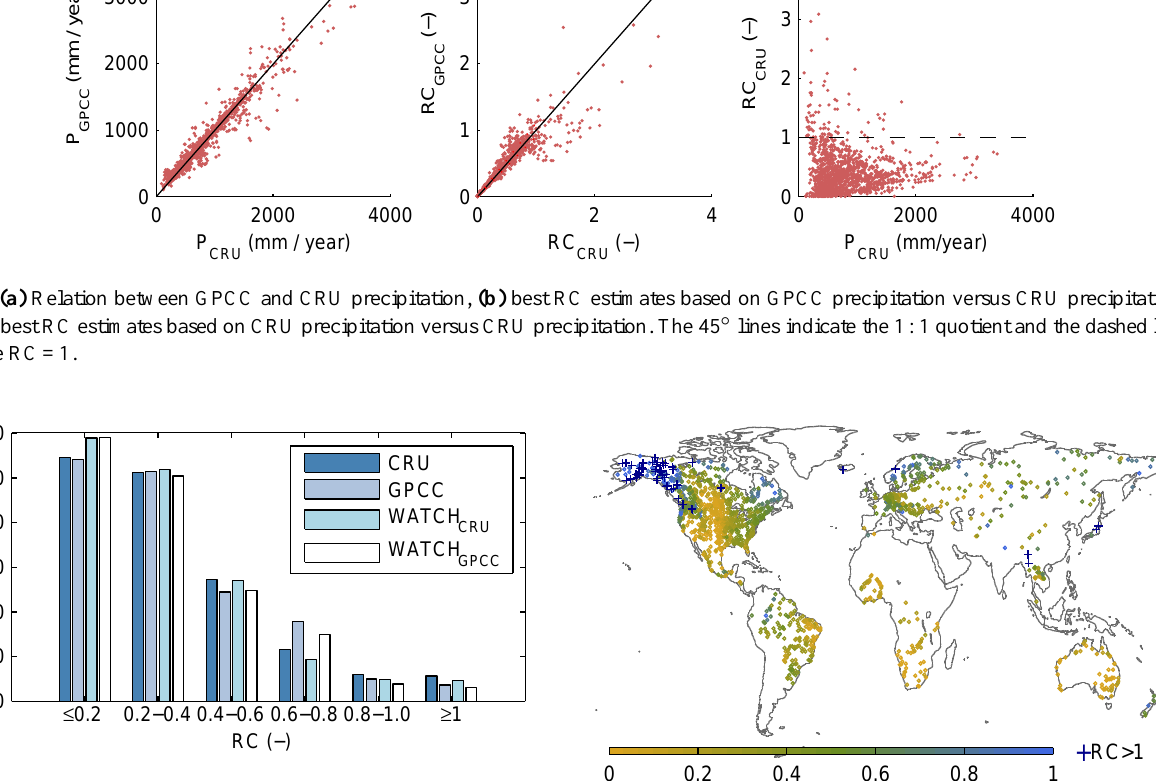
Fig. 7. Distribution of low-estimate RCs for the four precipitation datasets. Fig. 8. Spatial pattern of runoff coefficients for CRU precipitation. Circles represent best RC estimates and crosses represent basins with low RC estimates higher than